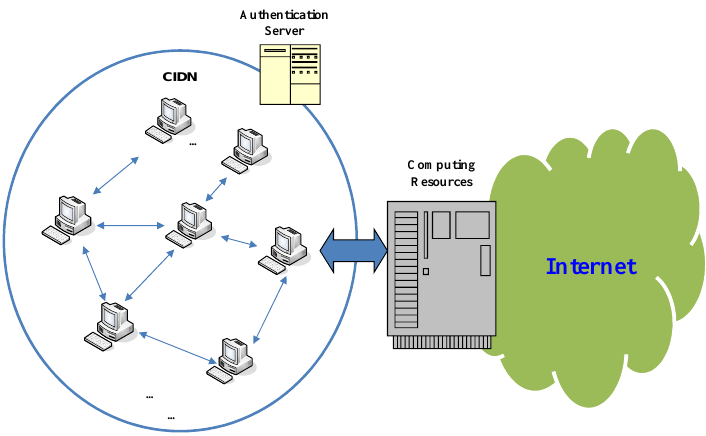
Figure 6. The high-level architecture of a real collaborative intrusion detection network (CIDN)